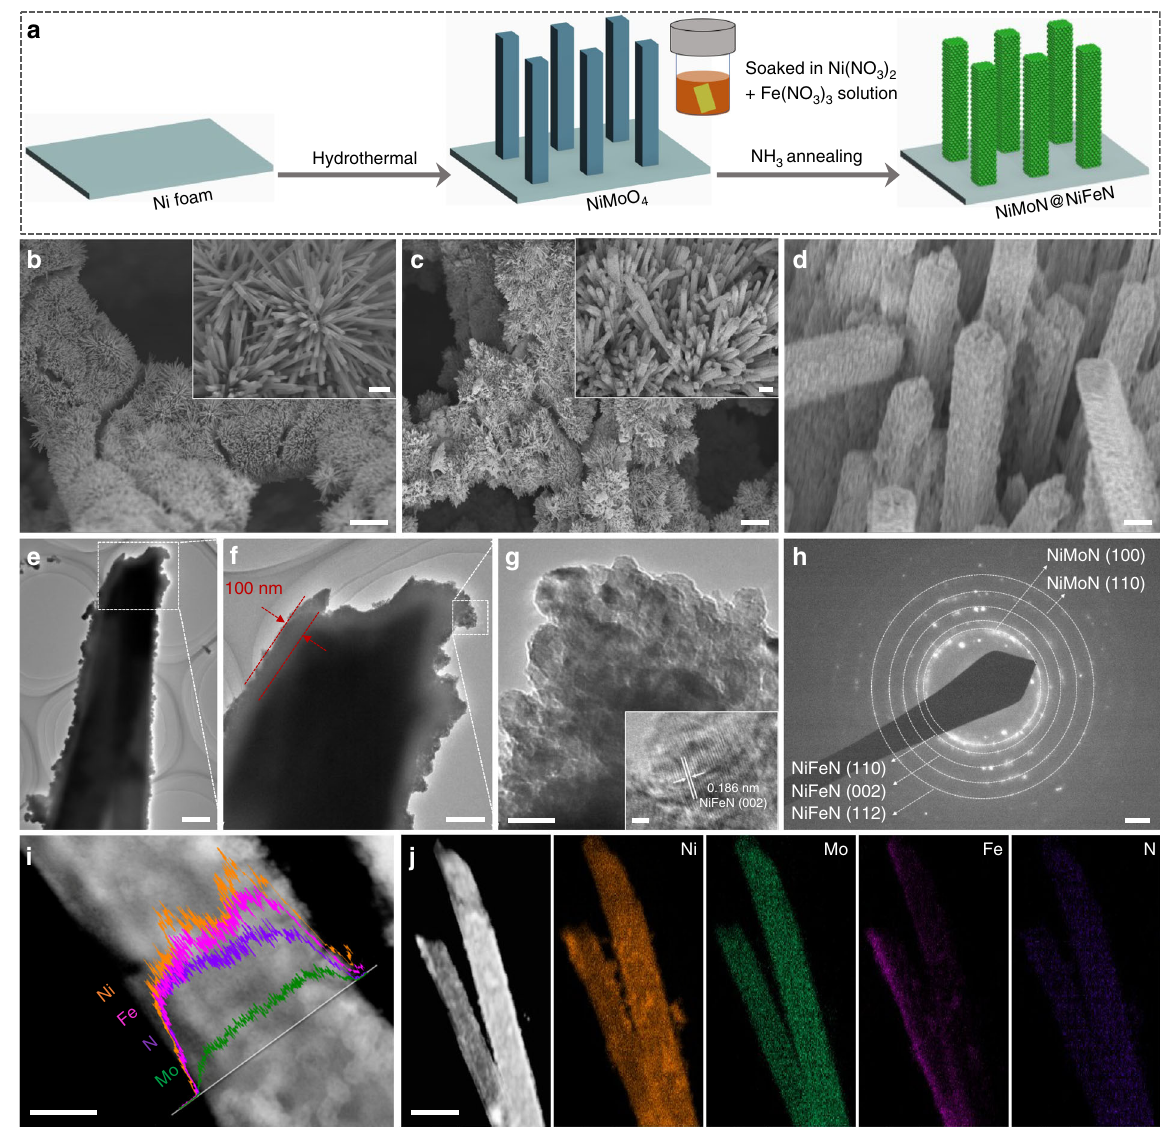
Fig. 1 Synthesis and microscopic characterization of the as-prepared NiMoN@NiFeN catalyst. a Schematic illustration of the synthesis procedures for the self-supported 3D core-shell NiMoN@NiFeN catalyst. b – d SEM images of ( b ) NiMoN and ( c , d ) NiMoN@NiFeN at different magni fi cations. e , f TEM images of NiMoN@NiFeN core-shell nanorods at different magni fi cations. g HRTEM image, h SAED pattern, i EDS line scan, and j dark fi eld scanning transmission electron microscopy (DF-STEM) image and corresponding elemental mapping of the NiMoN@NiFeN catalyst. Scale bars: b , c 30 µ m; insets of ( b , c ) 3 µ m; d , e 500 nm; f 200 nm; g 20 nm; inset of ( g ) 1 nm; h 2 1/nm; i 250 nm; j 1 µ